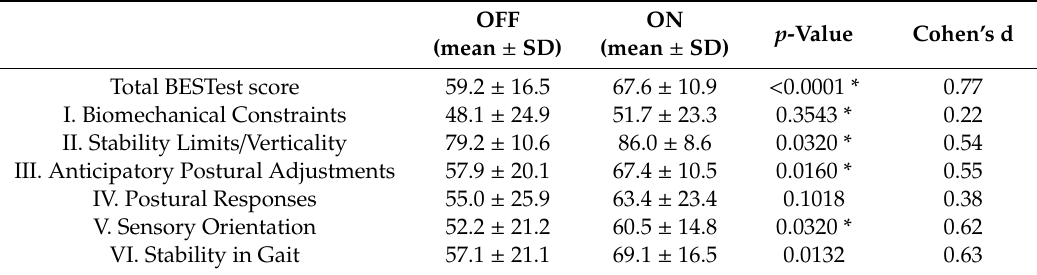
Table 2. BESTest Scores by